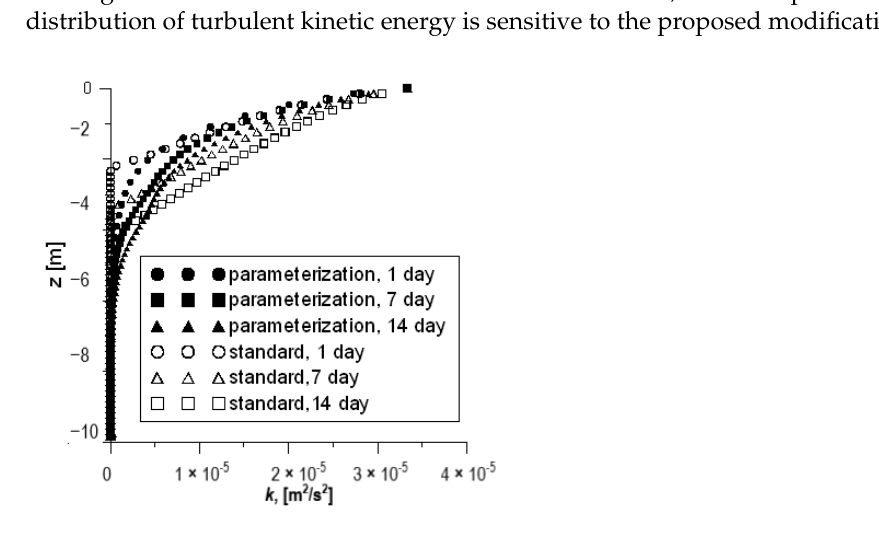
Figure 4. Profiles of the kinetic energy of turbulence using the standard and modified schemes in the lake.